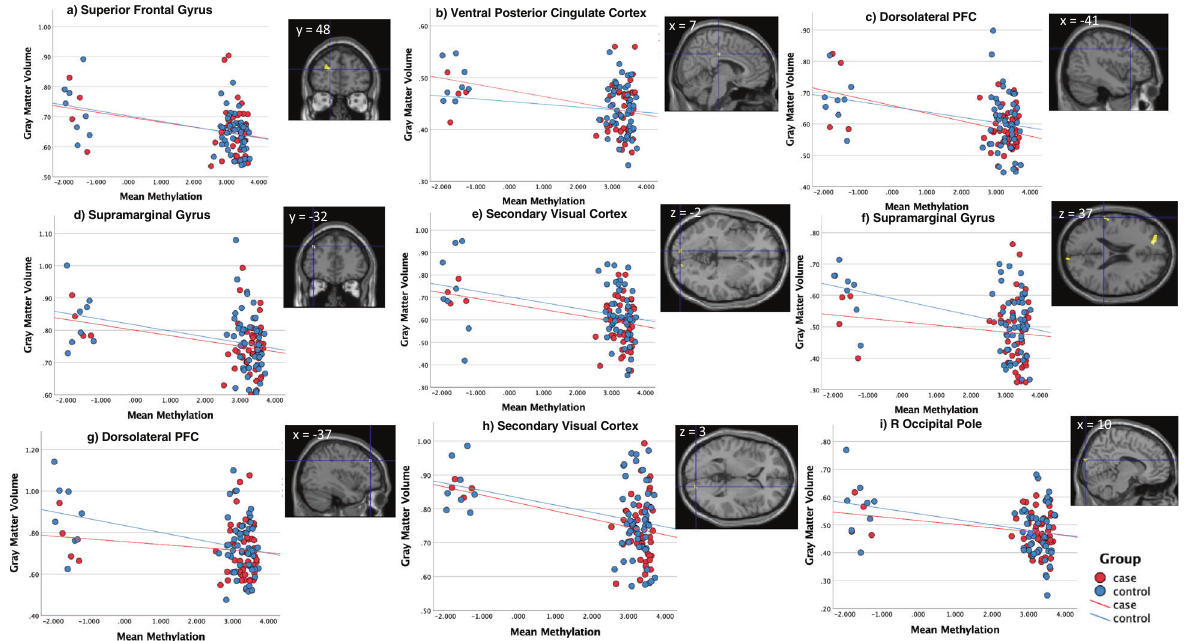
Fig. 2 Association between SLC25A24 methylation and gray matter volume. Mean gray matter volume (GMV) values in the cluster signi fi cantly associated with methylation for p < 0.001, size > 72 voxels were extracted for each participant and then plotted against the average methylation M -value across the DMR on chromosome 1 corresponding to exon 1 of gene SLC25A24. CD participants (red) and TD (blue) participants are differentiated by color. In all clusters there is a negative association between GMV and M value in both CD and TD groups; the difference between groups in the strength of the correlation is not statistically signi fi cant at p <